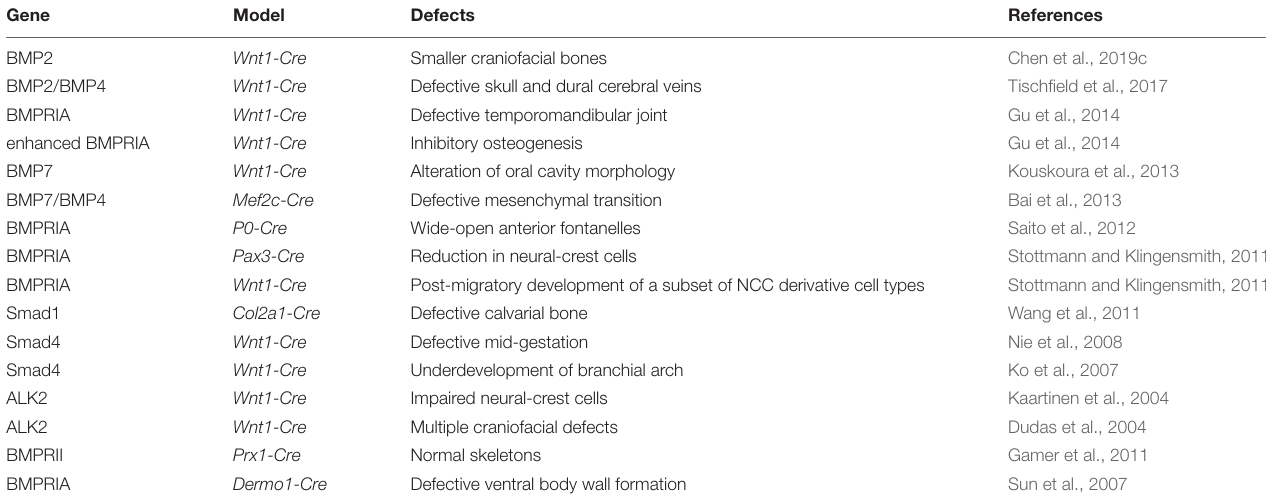
TABLE 1 | Functions of BMP signaling in the development of cranial